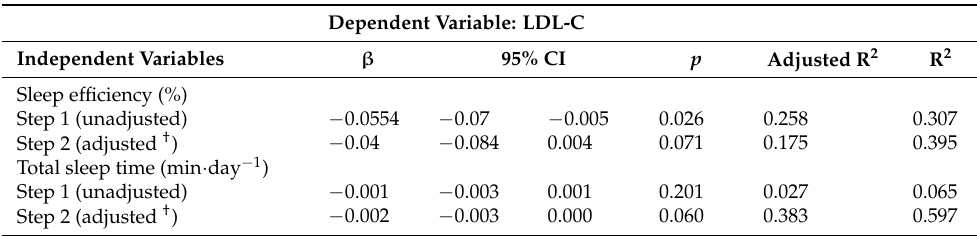
Table 3. Linear regression model examining the association between LDL-C and sleep parameters after adjusting for potential confounders in adolescents living without T1D.